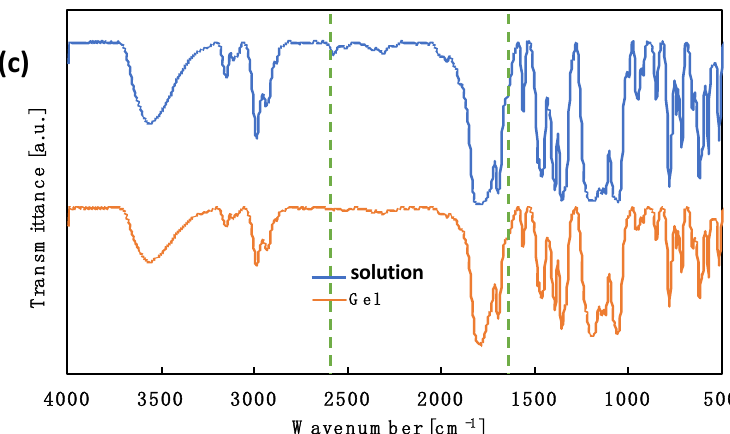
Figure 2. FTIR spectra of ( a ) the DPMP- DAIM TFSI system, before reaction (blue line), after reaction (orange line), solvent: Li-TFSI/PC (1 M), monomer concentration: 30 wt %, ( b ) the PEMP-DAIM TFSI system, before reaction (blue line), after reaction (orange line), solvent: Li-TFSI/PC (1 M), monomer concentration: 30 wt % and ( c ) the TEMPIC- DAIM TFSI system, before reaction (blue line), after reaction (orange line), solvent: Li-TFSI/PC (1 M), monomer concentration: 30 wt %.